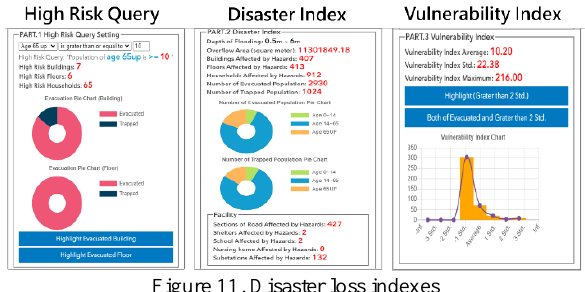
Figure 11. Disaster loss indexes